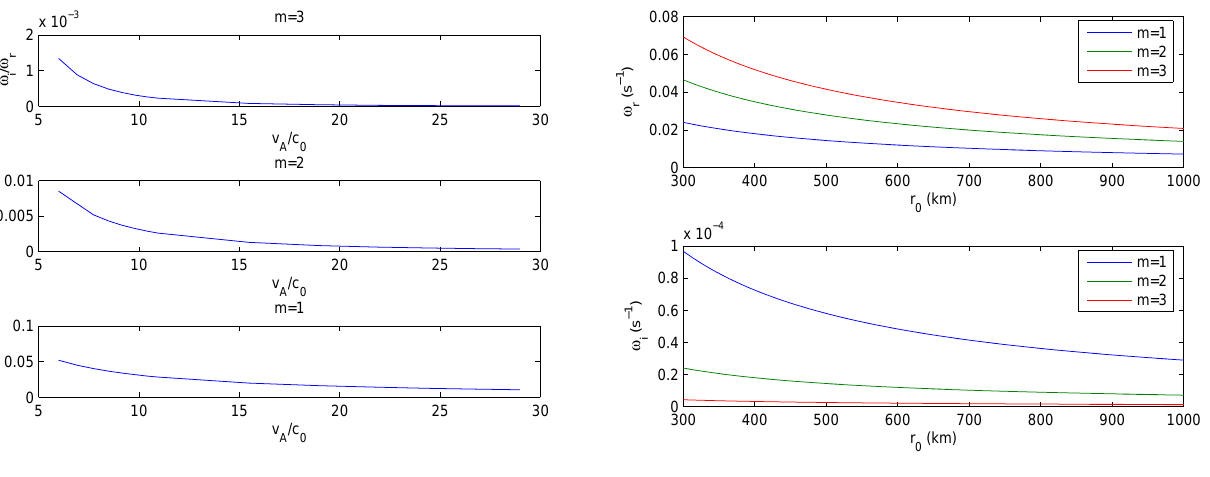
Fig. 4. Real ω r (upper panel) and imaginary ω i (lower panel) parts of wave frequency vs the radius of field-free cavity r 0 for m = 1 , 2 , 3 harmonics